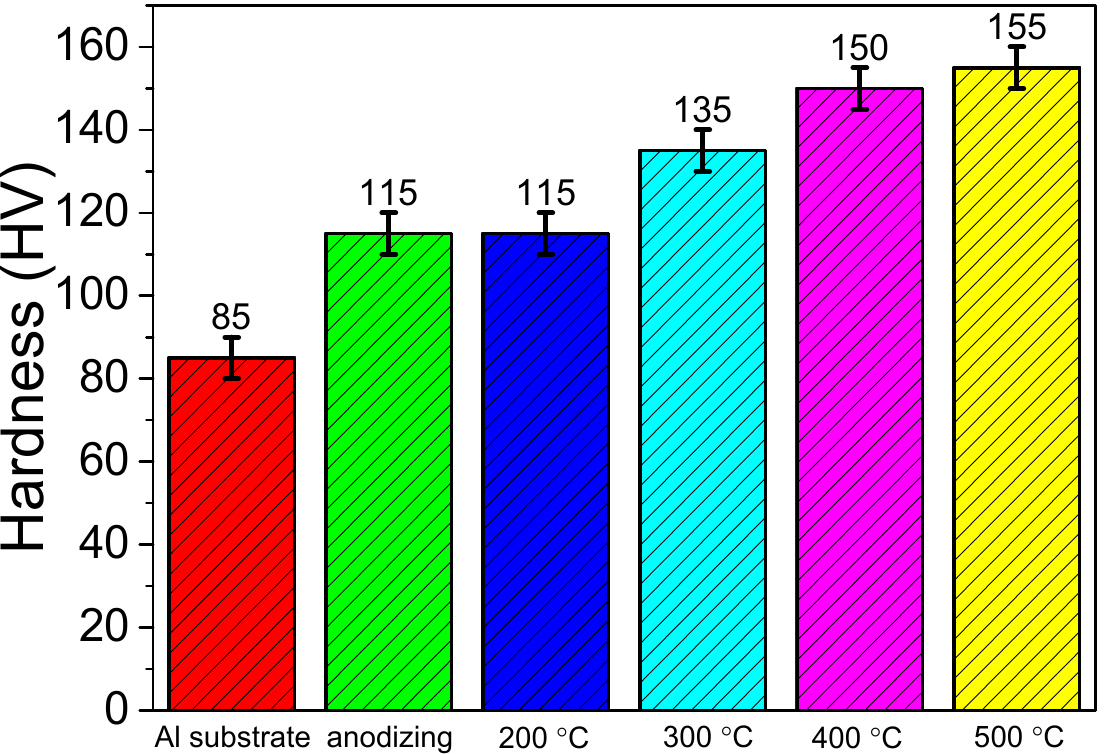
Figure 7. The hardness of anodic coating before and after being treated by hydro-thermal technology at 200 °C, 300 °C, 400 °C and 500 °C.